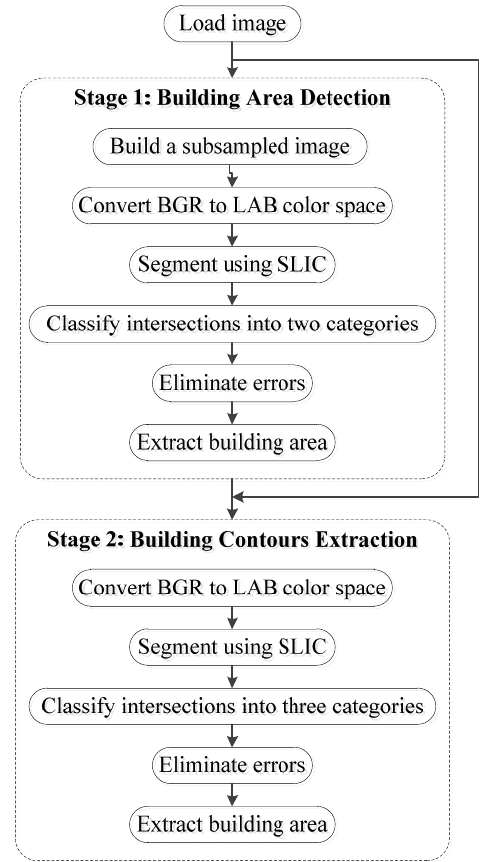
Figure 1 Proposed method for building